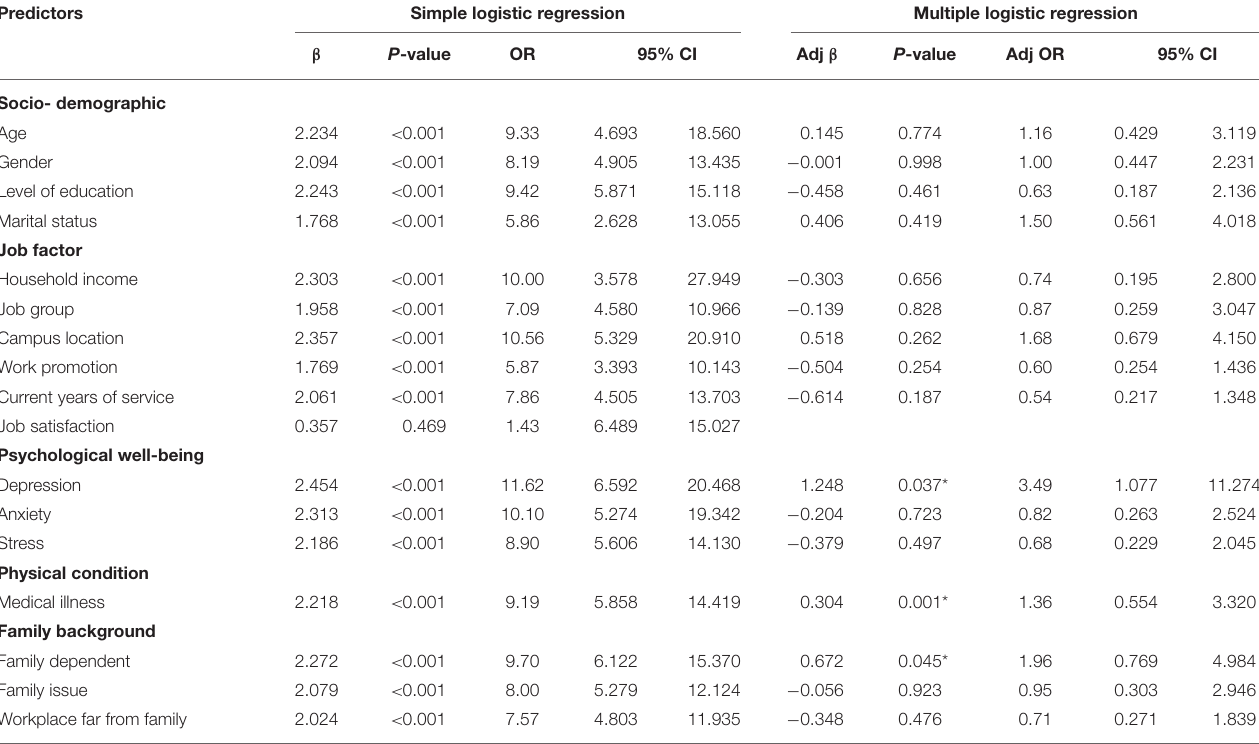
TABLE 2 | Logistic regression analyses for the predictors of WHOQOL-BREF P-QOL